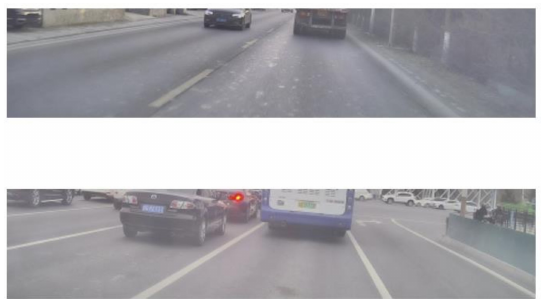
Figure 9. The data augmentation methods that can be used in the lane localization task: Rotation within a small angle (in our setting less than 10 degree in clockwise and counterclockwise) such rotation commonly encountered in real world application.